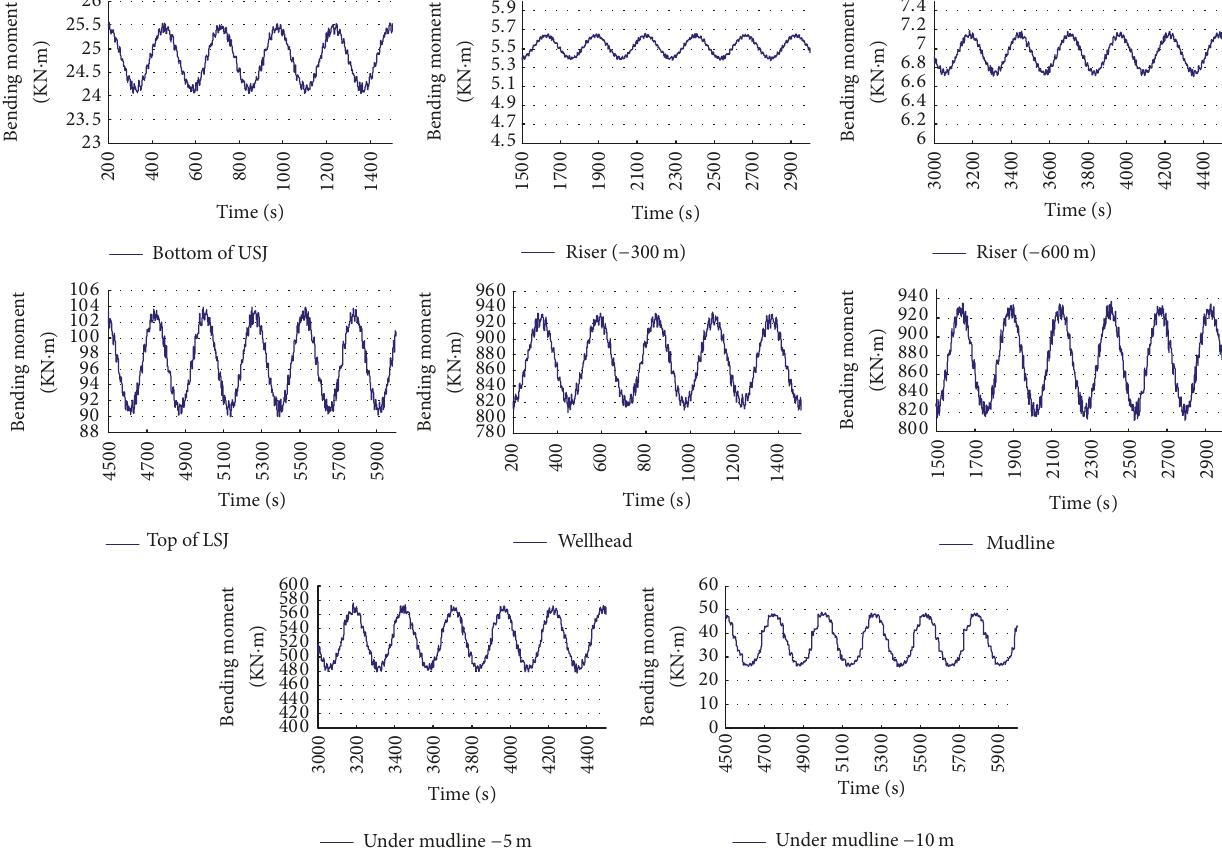
Figure 8: Dynamic bending moment on the riser, wellhead, and